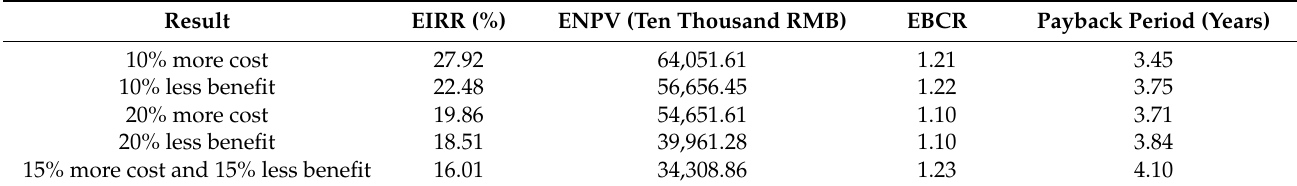
Table 9. National economic evaluation results (Low